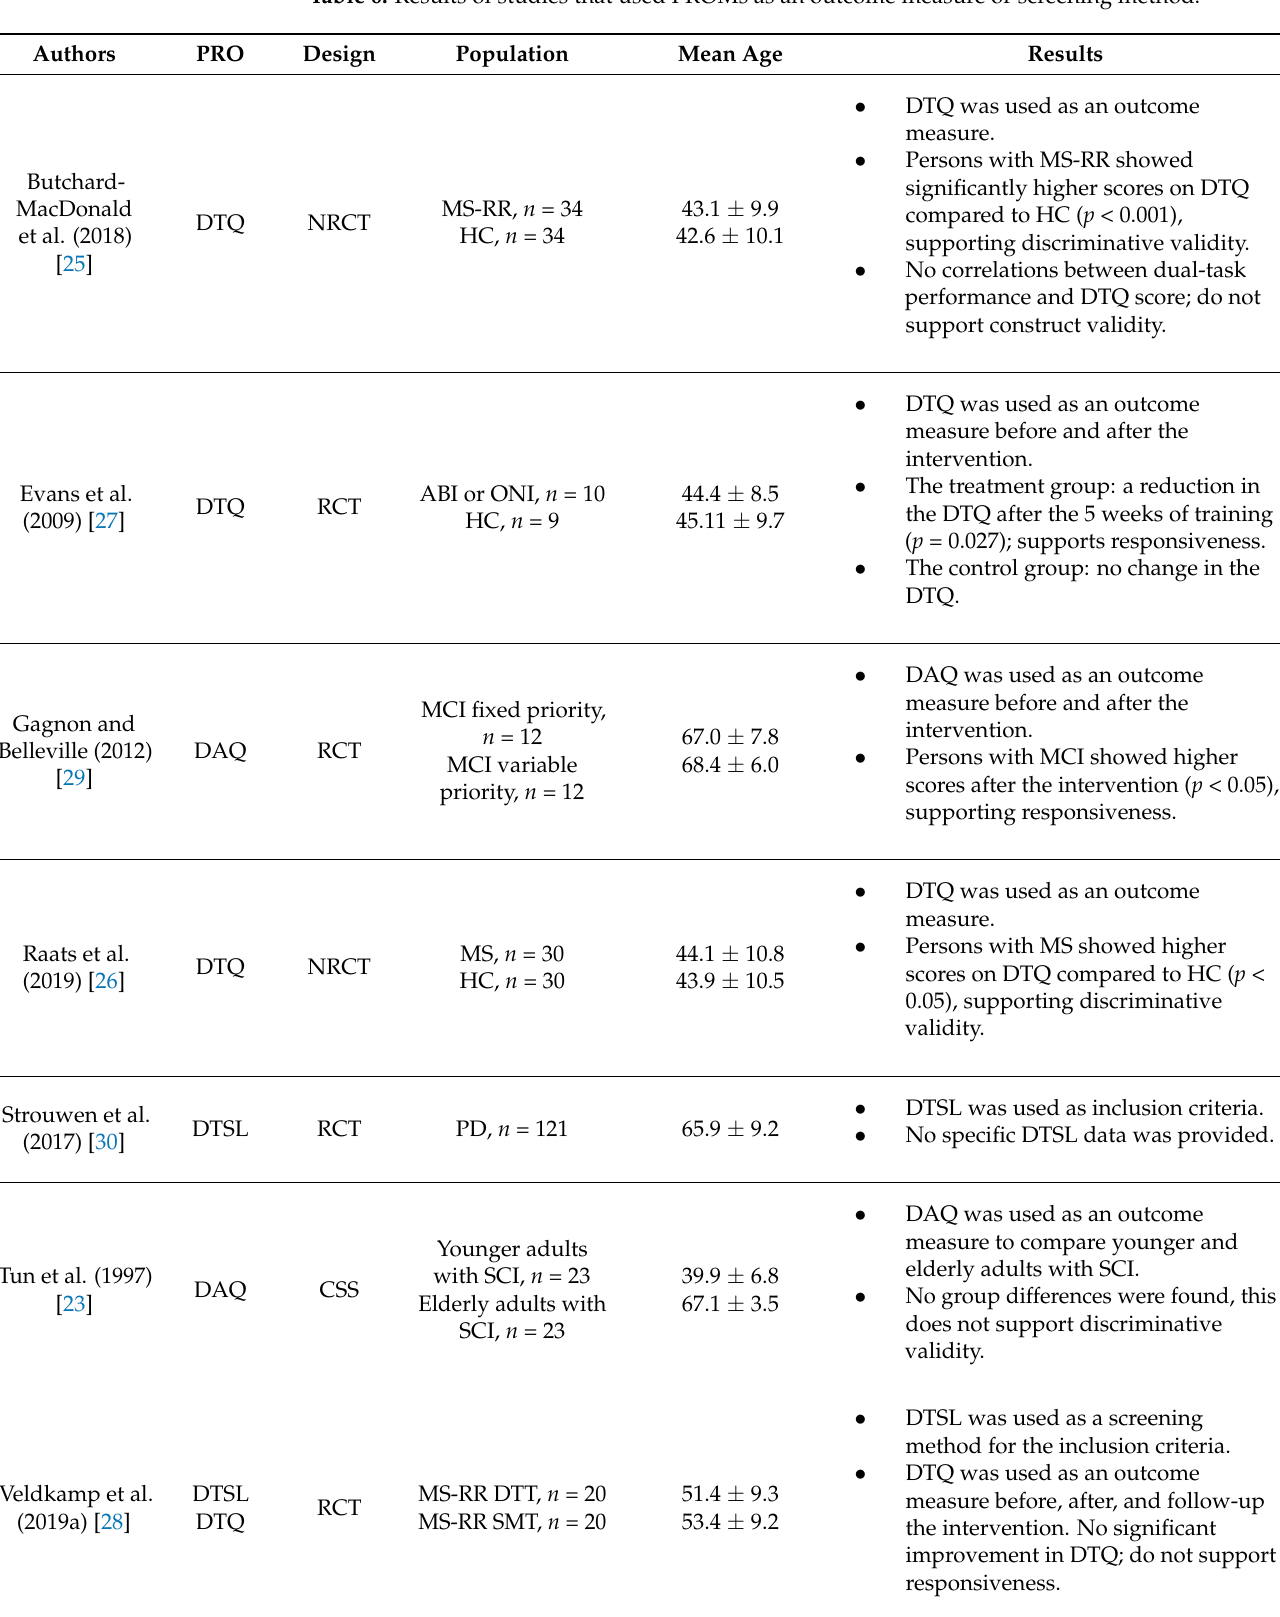
Table 6. Results of studies that used PROMs as an outcome measure or screening